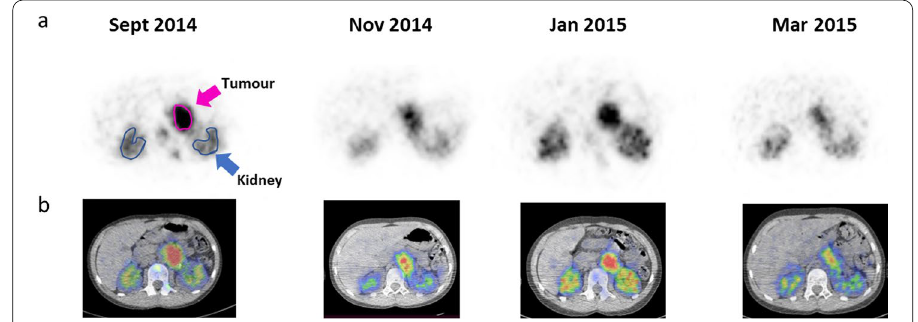
Fig. 1 Longitudinal SPECT images at 24 h after each cycle of [ 177 Lu]Lu-DOTATATE showing change in uptake of lesion over 24 weeks for Patient 1 as seen on the axial a SPECT and b SPECT/CT slices